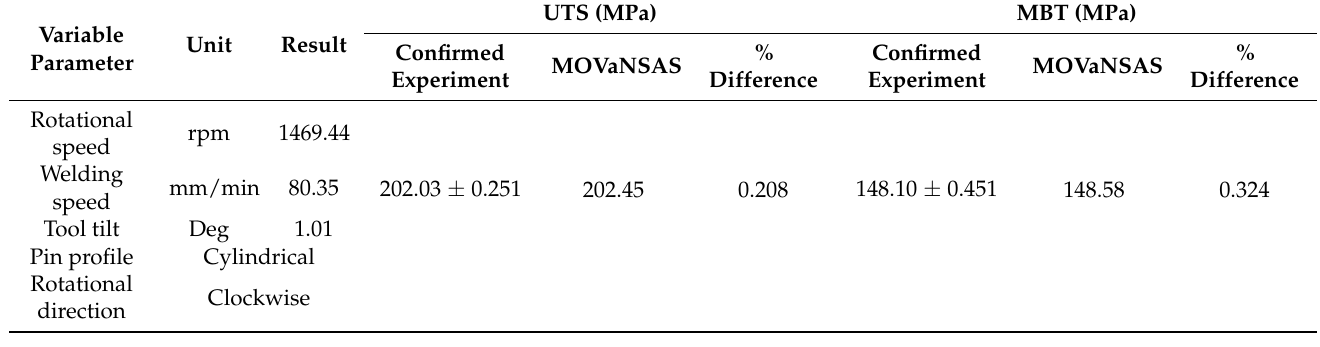
Table 13. Comparison of the experimental and the MOVaNSAS results.